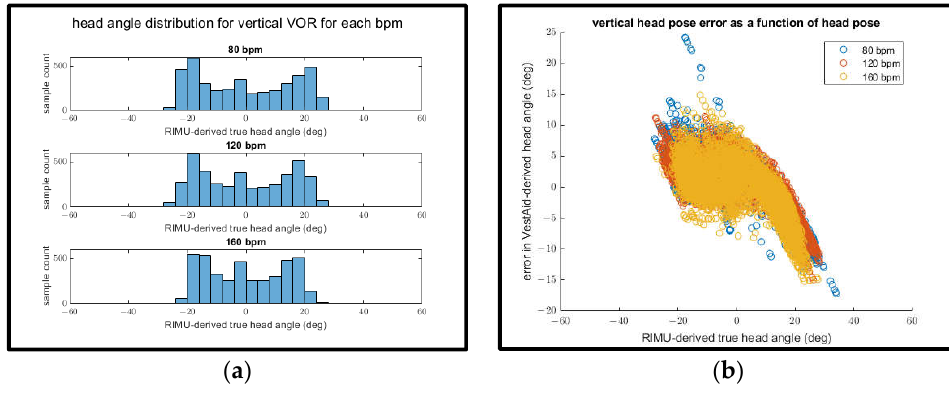
Figure 17. ( a ) IMU-derived head angle distribution for all trials of vertical VORx1 exercises at different bpms; ( b ) error in the vertical head pose angle vs. IMU-derived head angle.